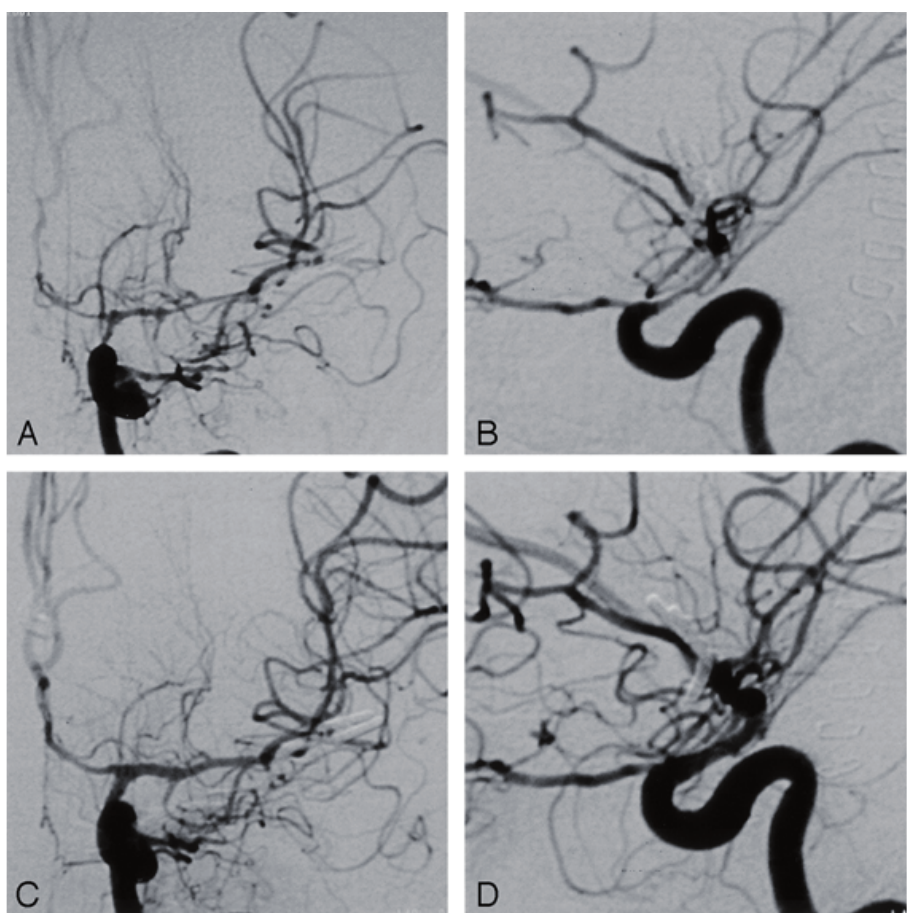
Figure 2. Angiograms demonstrating cerebral vessel narrowing after subarachnoid haemorrhage. A and B : Anteroposterior ( A ) and lateral ( B ) angiograms of the left internal carotid artery demonstrate vessel narrowing at the level of the carotid siphon, the terminal internal carotid artery, the A1 segment of the anterior cerebral artery and the middle cerebral artery. C and D : Anteroposterior ( C ) and lateral ( D ) angiograms obtained after intra-arterial injection of